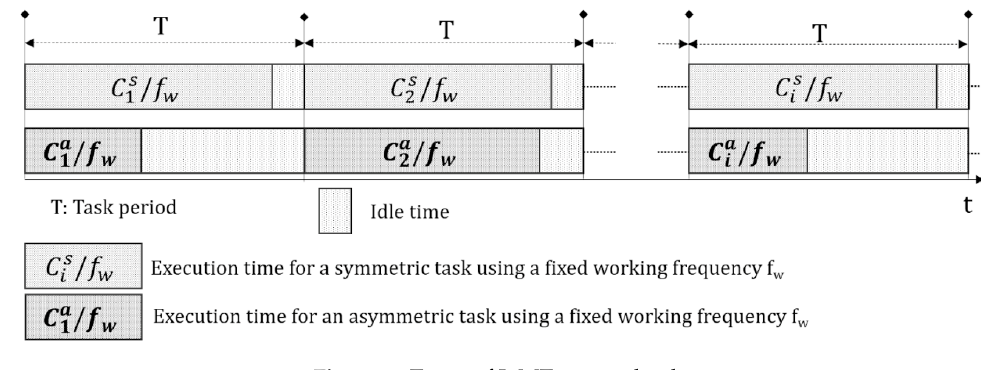
Figure 3. Types of IoMT system loads.